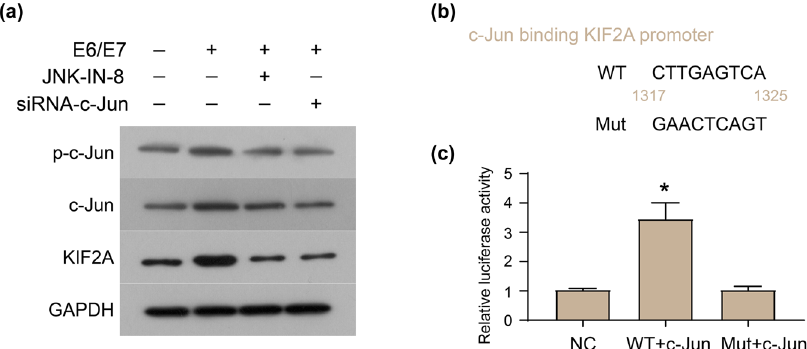
Figure 4: JNK substrate c - Jun drive KIF2A transcription. ( a ) Exogenous expression of E6/E7 in C33A cells increased the levels of c - Jun and p - c - Jun, and the JNK inhibitor ( JNK - IN - 8 ) and siRNA speci fi cally targeting c - Jun reduced the expression levels of c - Jun, p - c - Jun, and KIF2A induced by E6/E7. ( b ) PROMO was used to predict the site where c - Jun binds to the KIF2A promoter sequence. ( c ) Dual luciferase experiment was performed. * P < 0.05.